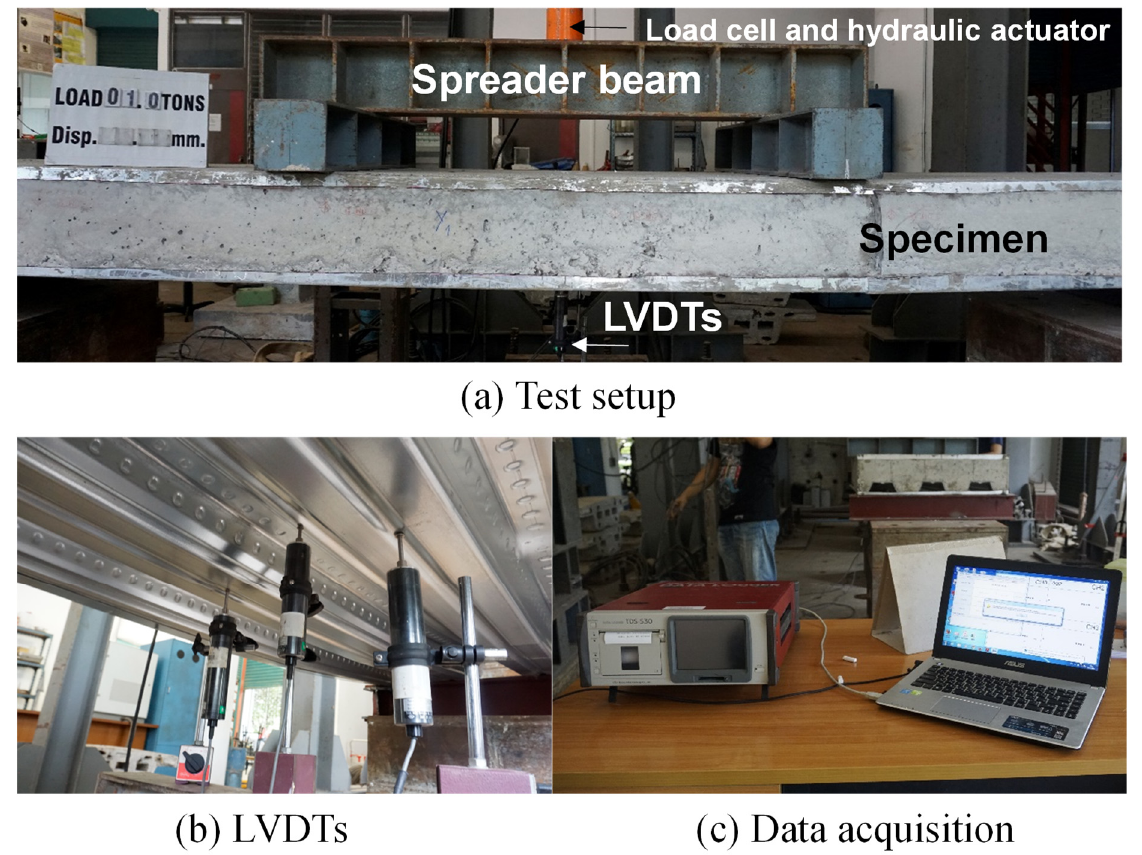
Figure 4. Test setup and instrumentation for testing the composite deck. ( a ) Installation of a representative beam for test preparation. ( b ) Positions of LVDTs. ( c ) Monitoring system.